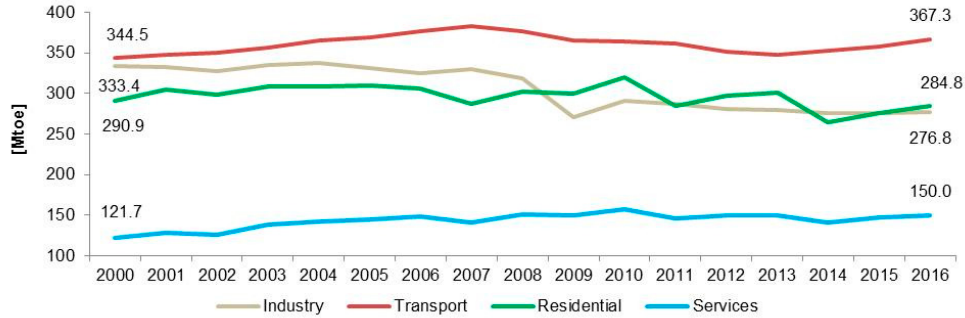
Figure 3. Dynamics of Final Energy Consumption FEC trends of the main sectors in the EU-28, 2000–2016. Source: Eurostat.